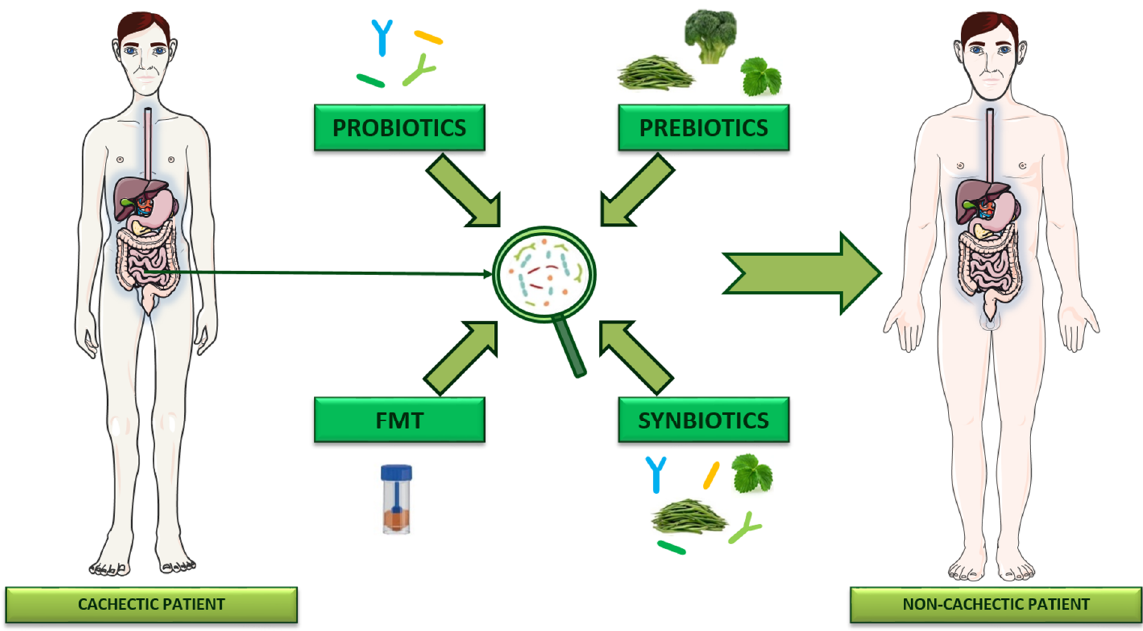
Figure 2. Emerging strategies of gut microbiota manipulation for the supportive treatment of cancer cachexia. Since a certain number of studies showed associations between gut microbiota and cachexia, strategies of microbiota manipulation through the administration of probiotics, prebiotics, synbiotics, or through fecal microbiota transplantation (FMT) from healthy donors are emerging to correct dysbiosis and likely improve cachexia outcome.